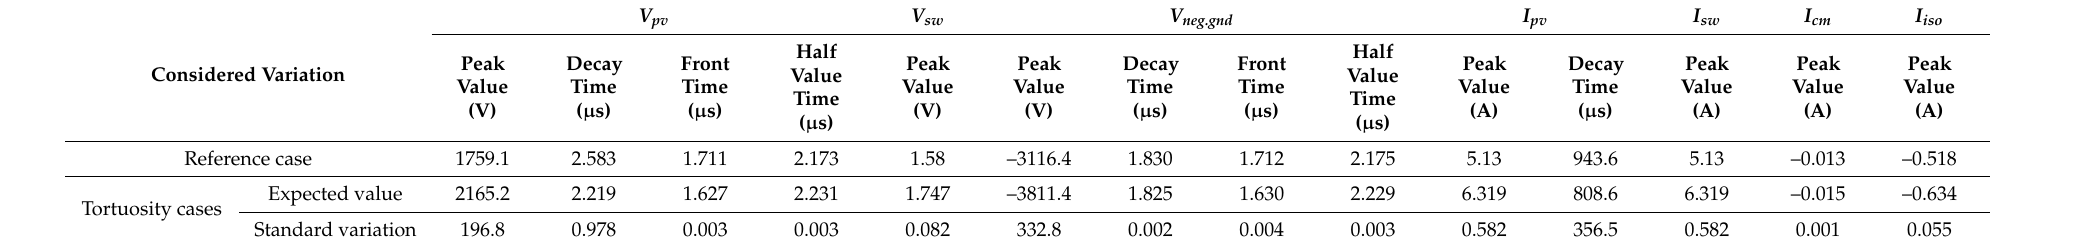
Table 8. Expected values and standard deviations for induced voltages and currents for various tortuosity